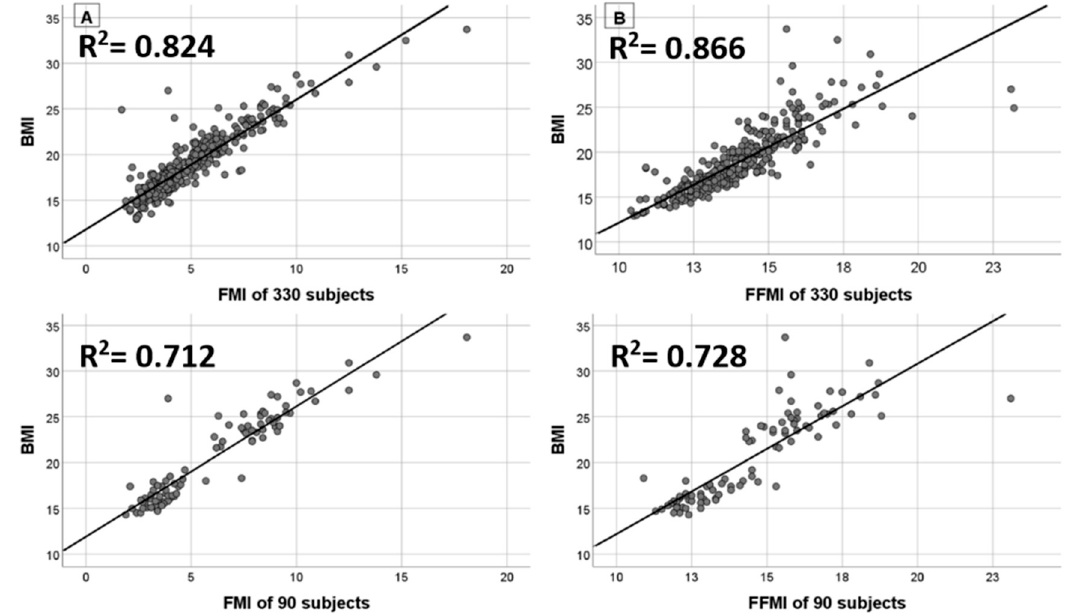
Figure 2. Linear regression between BMI and FMI on the left ( A ), and BMI and FFMI on the right ( B ). The upper-side scatterplots refer to the whole sample (n = 330) and the lower-side scatterplots refer to the subgroup of children categorised in accordance with all BMI standards simultaneously (n = 90).